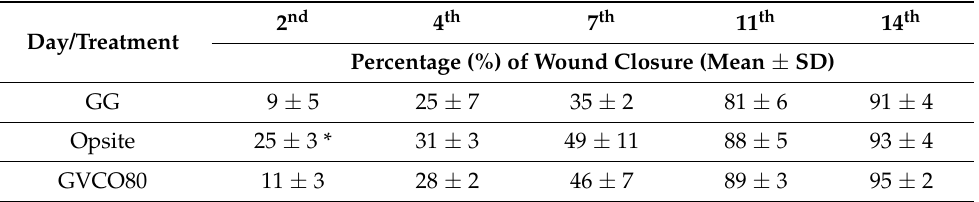
Table 4. The percentage of wound contraction of experiment groups on days 2, 4, 7, 11, and 14; the means of two replicates where Opsite acts as a control; * ( p < 0.05 compare with the control group). 2 Day/Treatment